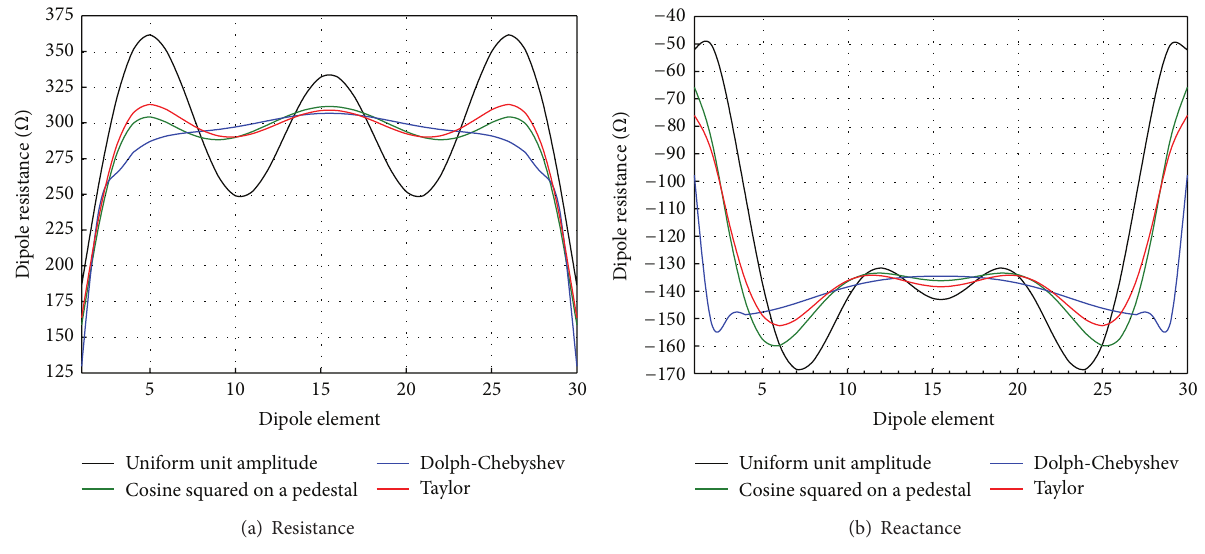
Figure 2: Terminal impedance 𝑍 𝑎